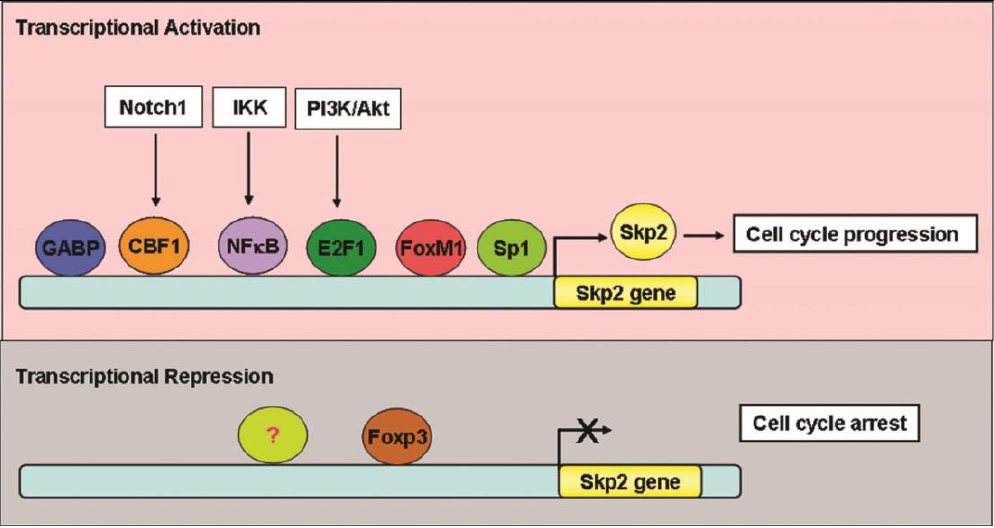
FIGURE 2. Regulation of Skp2 gene expression . GABP, controlled by cell cycle; CBF1, mediated by Notch signaling; NF-kB, triggered by IKK/NF-kB signaling; E2F1, regulated by PI3K/Akt signaling, are shown to bind to Skp2 promoter region and are required for Skp2 gene expression and cell cycle progression. FoxM1 and Sp1 have been also shown to regulate Skp2 transcriptional activation. Foxp3, a recent identified tumor suppressor, can bind to the Skp2 promoter and repress Skp2 gene expression to induce cell cycle